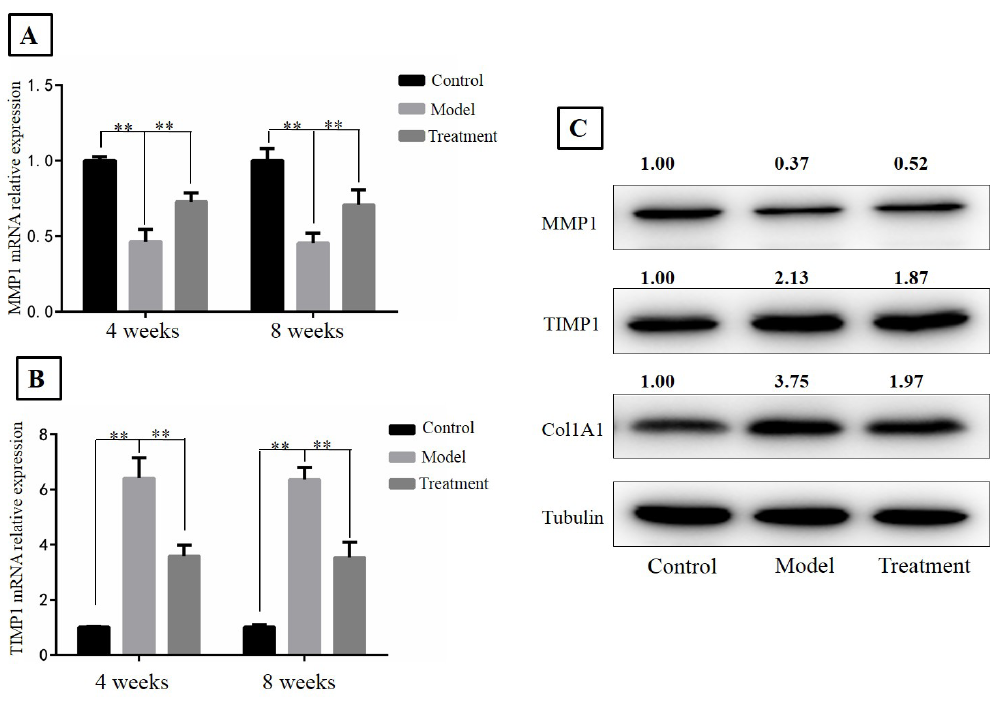
Figure 4: Relative gene and protein expression of MMP1 and TIMP1 in the liver tissues. A: gene expression of MMP1 in the liver tissues of rats at Weeks 4 and 8; B: gene expression of TIMP1 in the liver tissues of rats at Weeks 4 and 8. C: protein expression of MMP1, TIMP1, and Col1A1 in liver tissues of rats at Week 8. The relative expression levels of proteins are marked above the protein